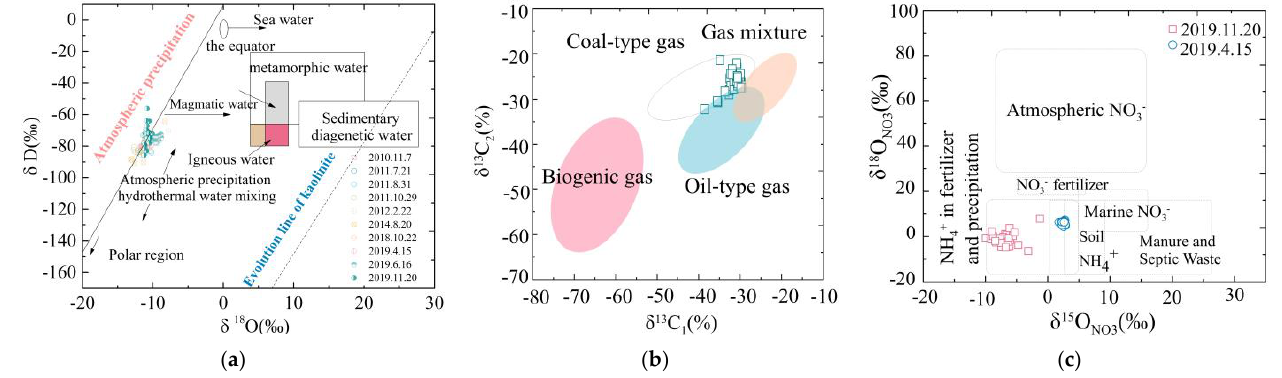
Figure 3. Geochemical characteristics of water samples in the study area: ( a ) hydrogen and oxygen isotopes of H 2 O (‰), ( b ) carbon isotopes of CH 4 (‰) and ( c ) nitrogen and oxygen isotopes of nitrate (‰).